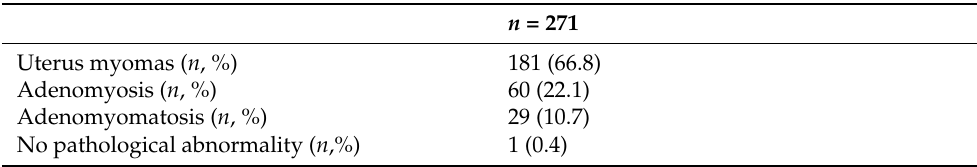
Table 2. Main Histopathological Uterine Results.